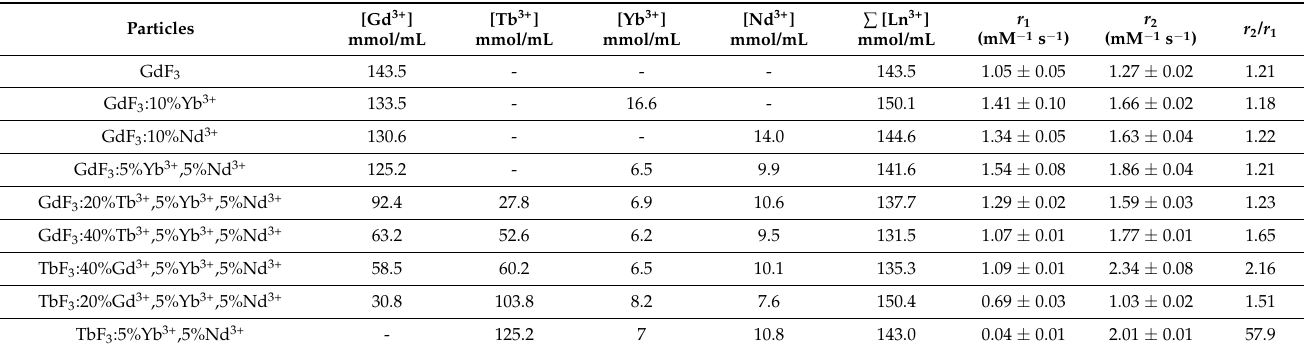
Table 2. Relaxometry of aqueous Gd(Tb)F 3 :Tb 3+ (Gd 3+ ),Yb 3+ ,Nd 3+ @P(DMA-AGME)-Ale nanoparticle dispersions measured at 23 °C.